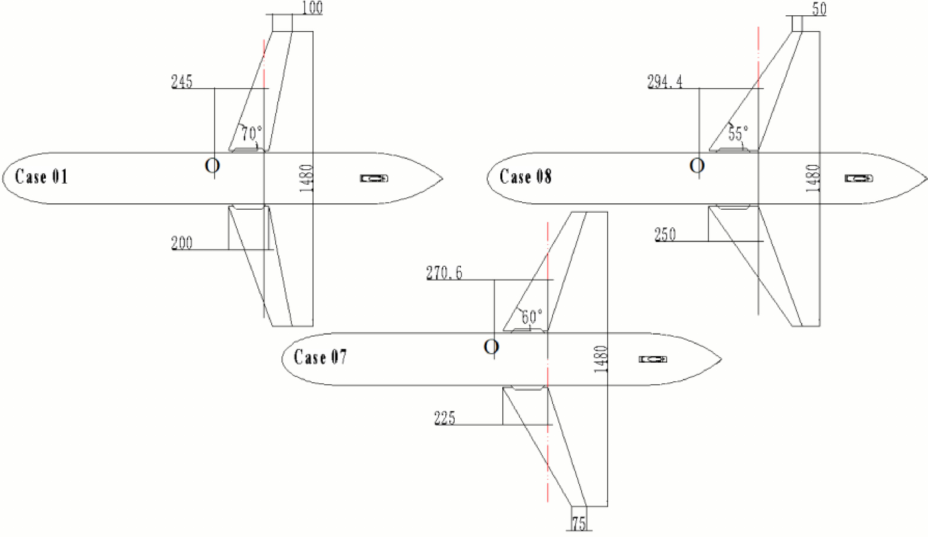
Figure 6. Various wing